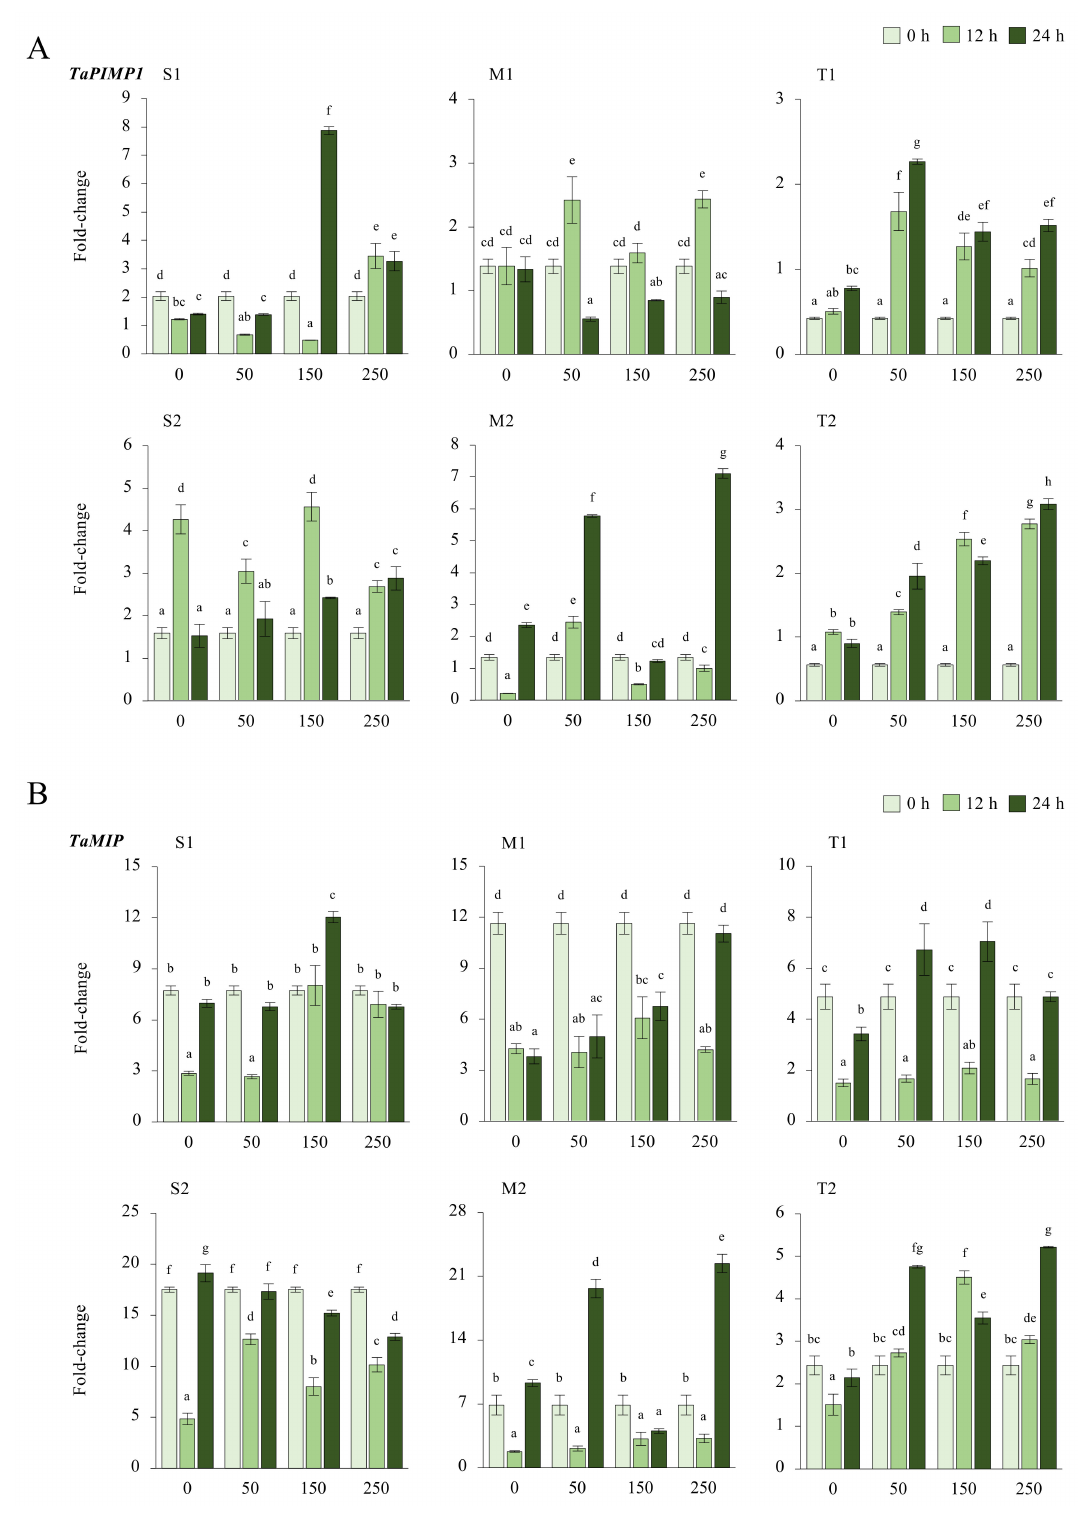
Figure A4. ( A ) The gene expression of the TaPIMP1 , and ( B ) TaMIP in the leaves of salt-sensitive (S1), S2, -moderate (M1), M2, -tolerant (T1), and T2 genotypes exposed to 0, 50, 150, and 250 mM NaCl stress for 0, 12, 14 h. The Cq values formed the basis of qRT-PCR. The reference gene TaACTIN was used to standardize the Cq value for each sample. Means ( ± standard deviation) within the same graph followed by letters are significantly different at p < 0.05 according to the Tukey HSD test from independent biological triplicates ( n =